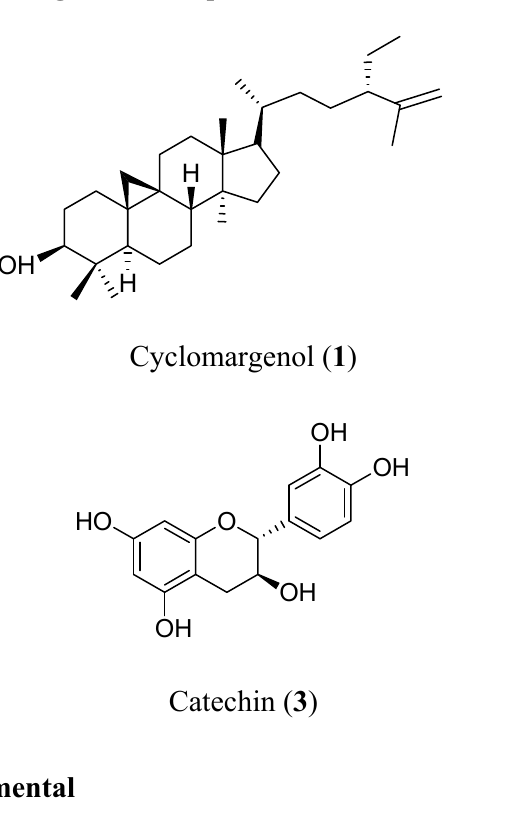
Figure 4. Compounds characterized from the K. pauciflora methanol